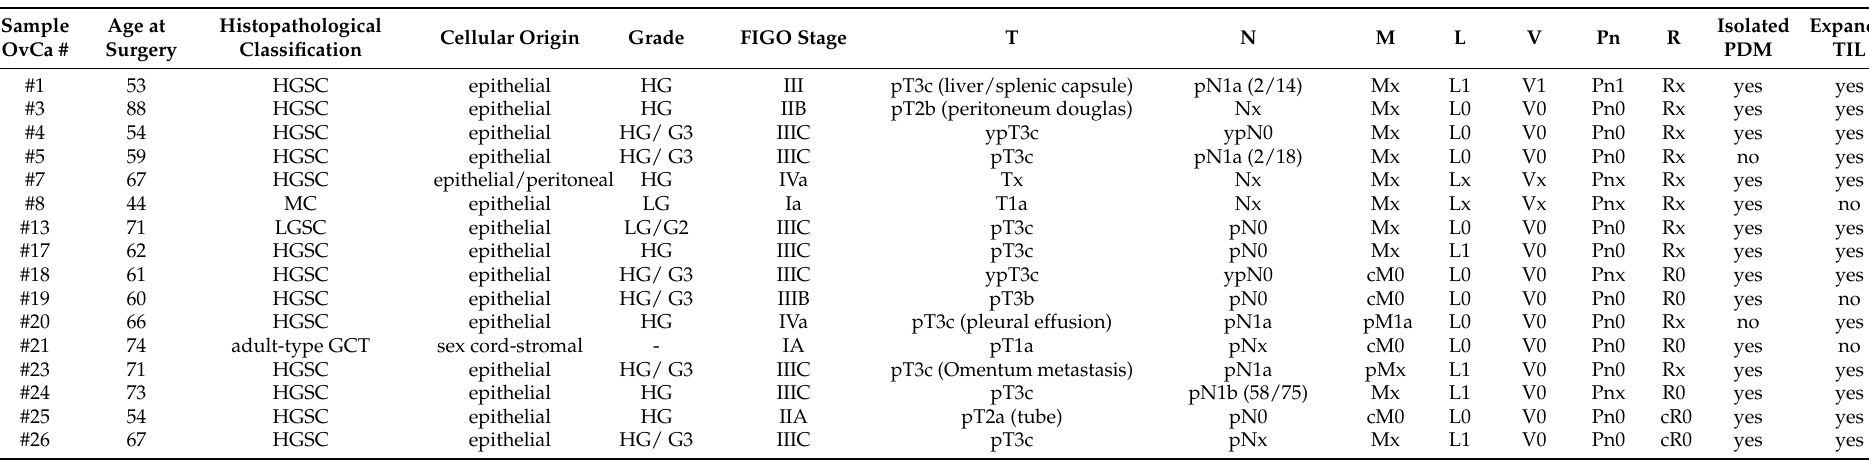
Table 1. Clinical patient data from OvCa tumor specimen included into the study with successful PDM isolation and/or TIL expansion. Sample OvCa